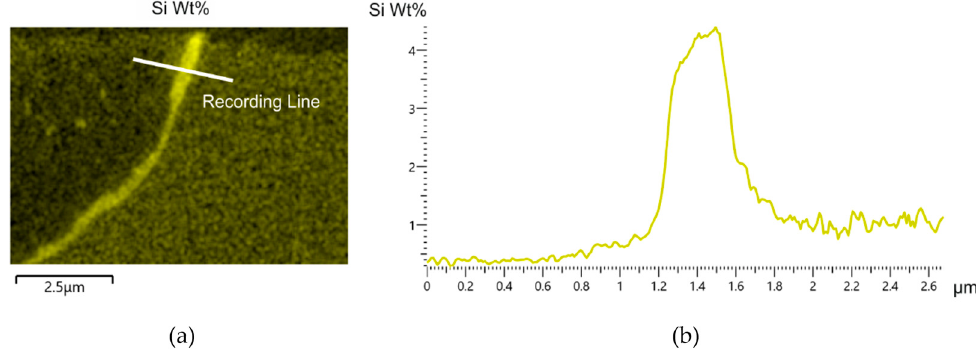
Figure 16. EDS analysis of a sample with Geometry C, ( a ) distribution of silicon, and ( b ) silicon content in wt.% near the joining zone.